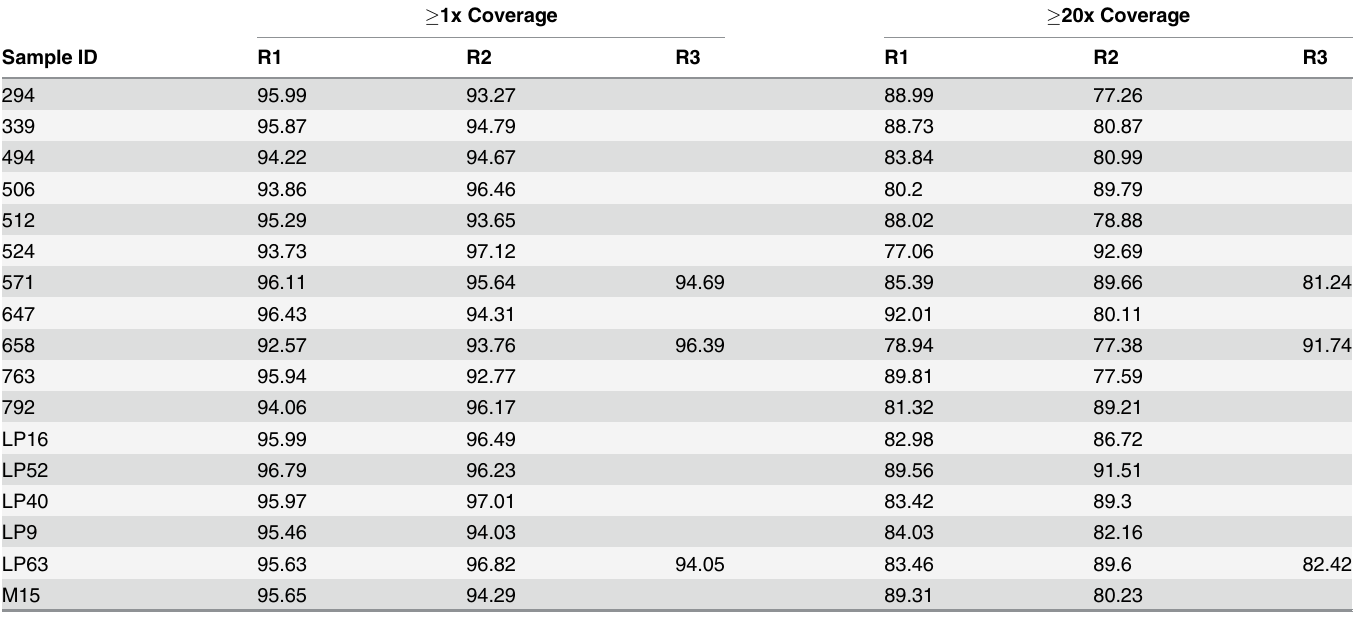
Table 1. The percentage of target base pairs with at least 1x or 20x coverage for each replicated sample. (cid:3) 1x